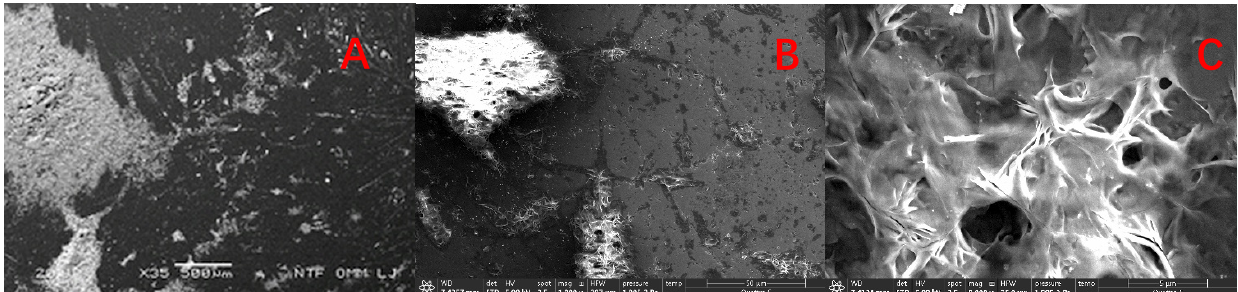
Figure 2. SEM results with three different magnifications of the electrode surface: ( A ) 35× ( B ) 1000× ( C ) 8000×; film was electrodeposited on a polished glassy carbon electrode ( E dep = − 0.850 V; t dep = 60 min).